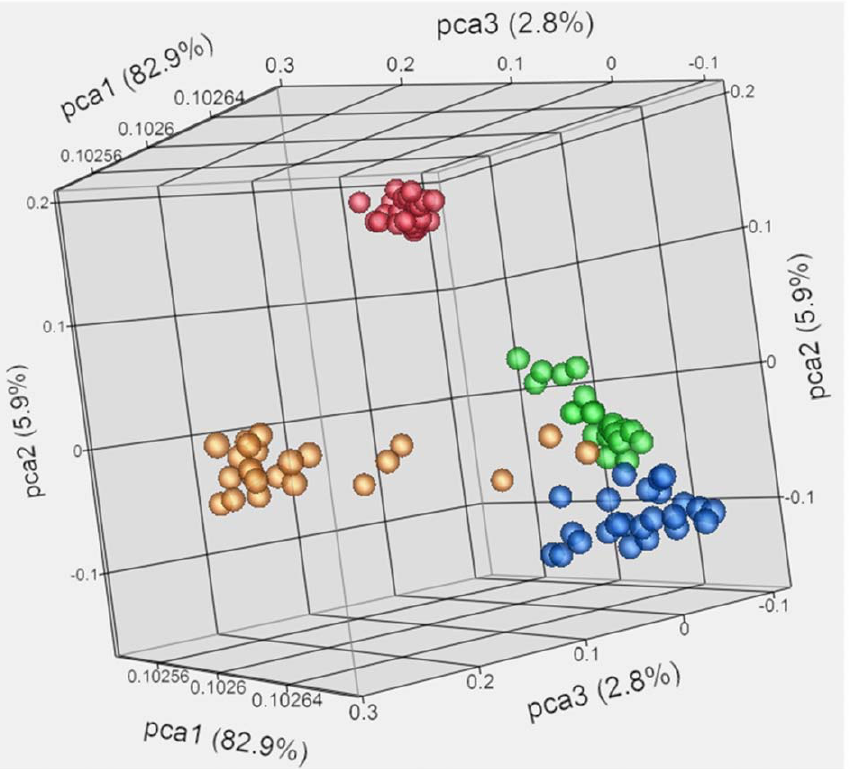
Figure 2. PCA analysis of DNA methylation levels from all monkeys eating each diet. Four clusters can be observed, distinguished by the tissue type. The axes are based on the eigenvalues of the three principal components determined. Tissues are differentiated by color: liver, gold; muscle, blue; fat, green; and blood, red.